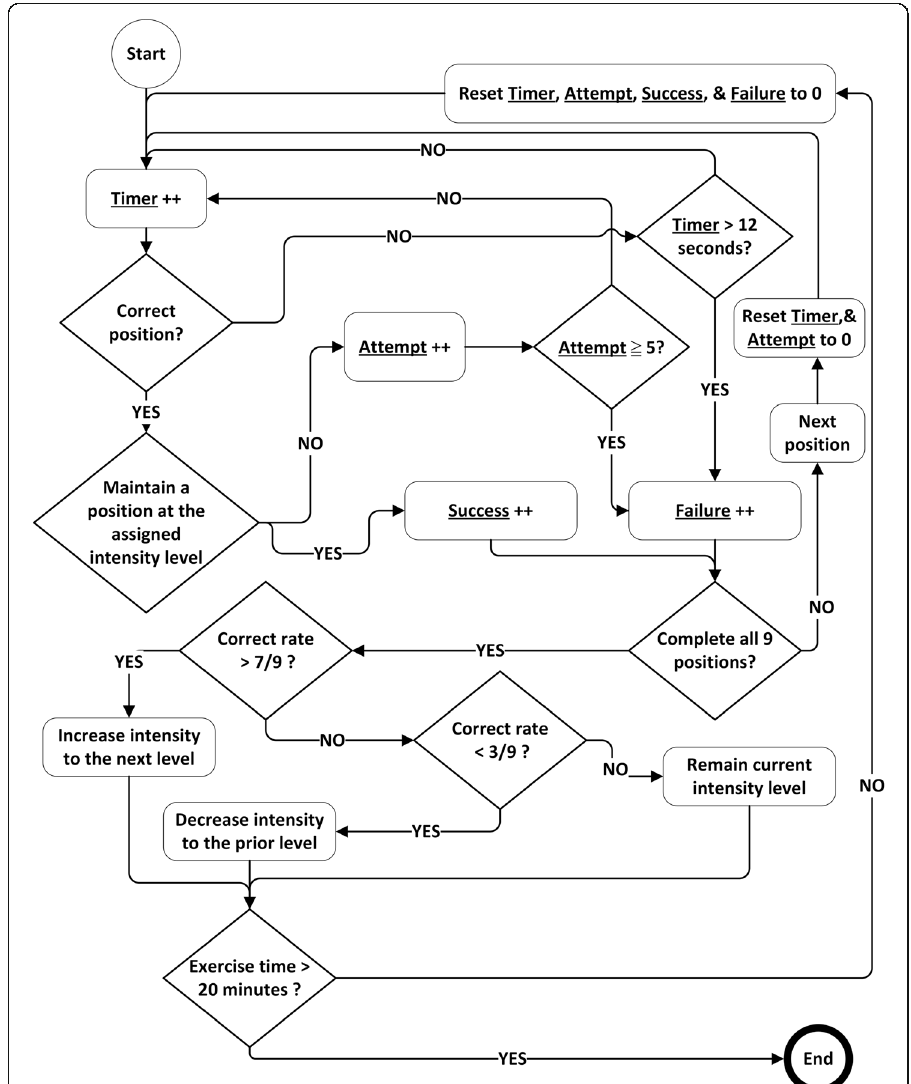
Fig. 2 The flowchart of the single adaptive